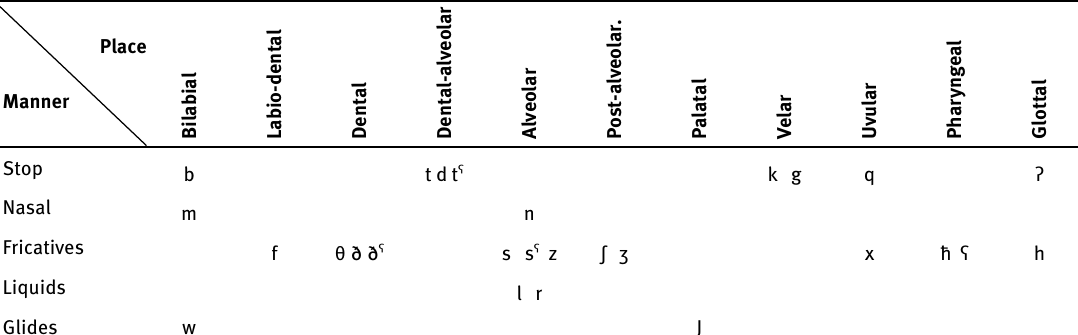
Table 3. Consonant inventory of